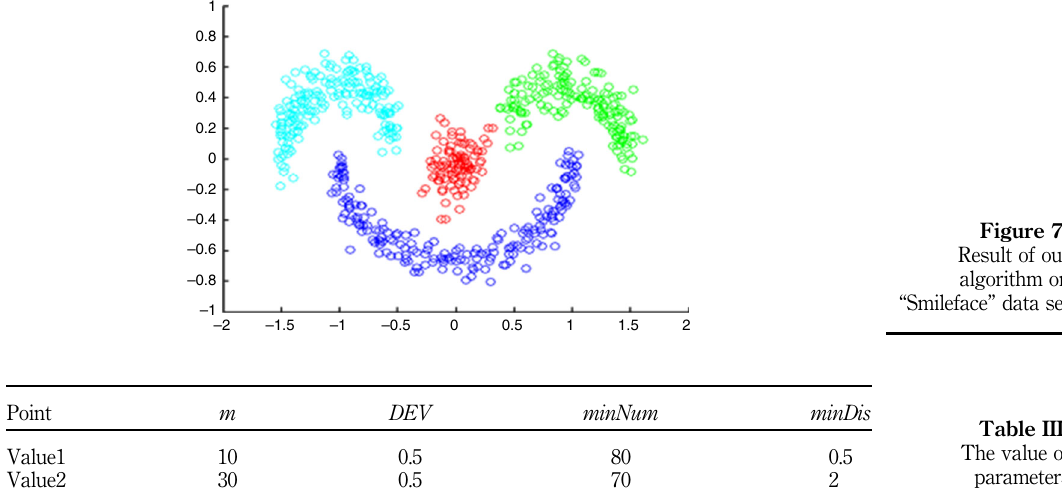
Table III. The value